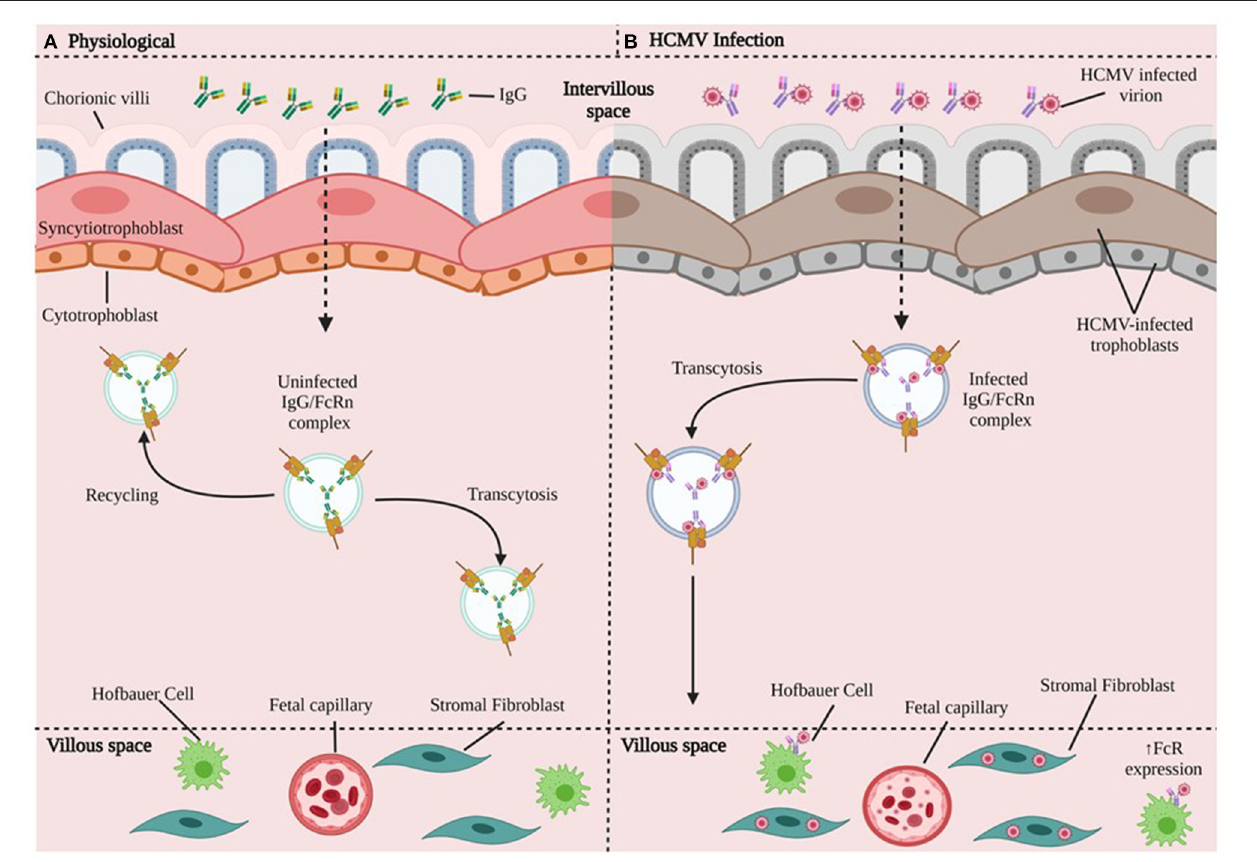
FIGURE 4 | HCMV transmission in chorionic villi. (A) In the physiologic state, maternal IgG binds FcRn in endosomes and can take different paths: either recycle (going back to the surface) or undergo transcytosis toward the basal membrane and bind to cells that express FcR. (B) HCMV Infection. The HCMV-infected virion disrupts trophoblast cells and forms HCMV IgG immune complexes that undergo FcR-mediated transcytosis. The HCMV-IgG immune complex can go on to infect HCs, fibroblasts, fetal capillaries. HCMV may be able to increase the expression of FcR (59). CTBs are important sites for placental HCMV infection, most likely transmit virus to the fetus, and HCMV could disseminate to the placenta by co-opting the receptor-mediated transport pathway for